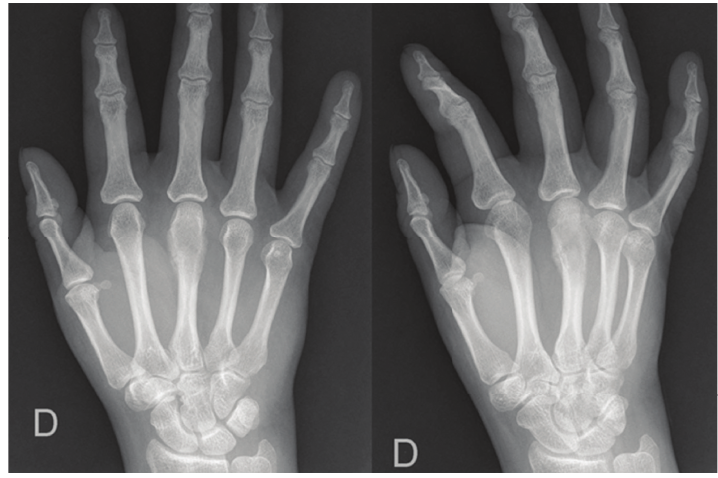
Figure 2: Radiograph taken 3 months postoperatively indicating that the patient had local recurrence.